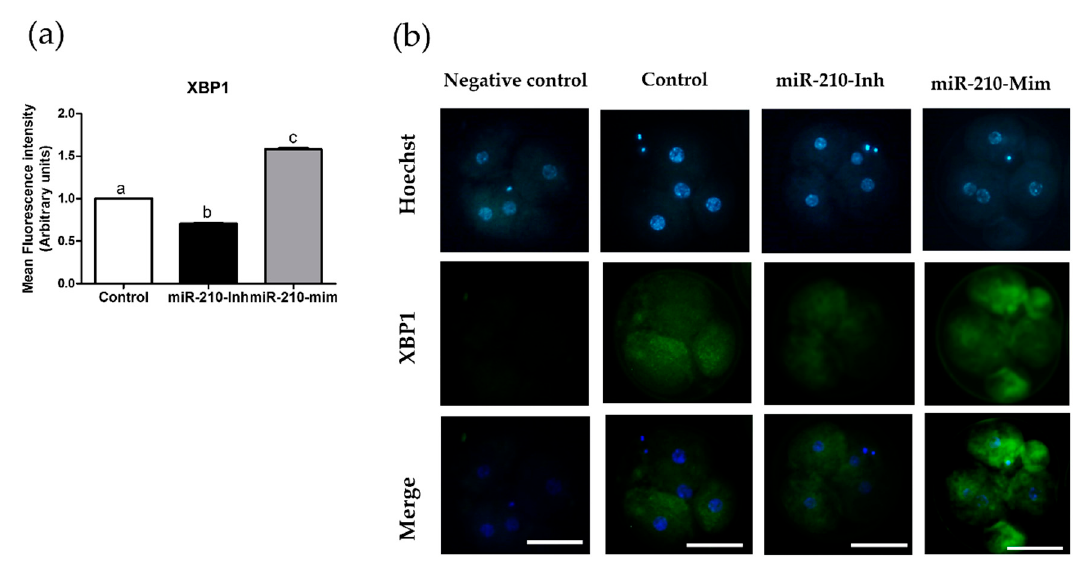
Figure 1. Expression levels of XBP1 , shown as fluorescence intensity at cleavage stage of microinjected embryos. ( a ) Chart showing the assessment of fluorescence intensity of XBP1 . At least 24 embryos per group from four biological replicates were analyzed. Data are presented as mean ± SEM. Treatment groups pointed out with letters are considered to be statistically significant ( p < 0.05). ( b ) Images showing immunofluorescence staining of embryos (green) in the control, miR-210-inhibitor, and miR-210-mimic treatment groups. Hoechst staining was used to stain DNA (blue), and merged images were created to demonstrate colocalization (scale bars 50 µ m; 400 × magnification). miR-210-Inh, micro-RNA-inhibitor; miR-210-Mim, micro-RNA-mimic; SEM, standard error of